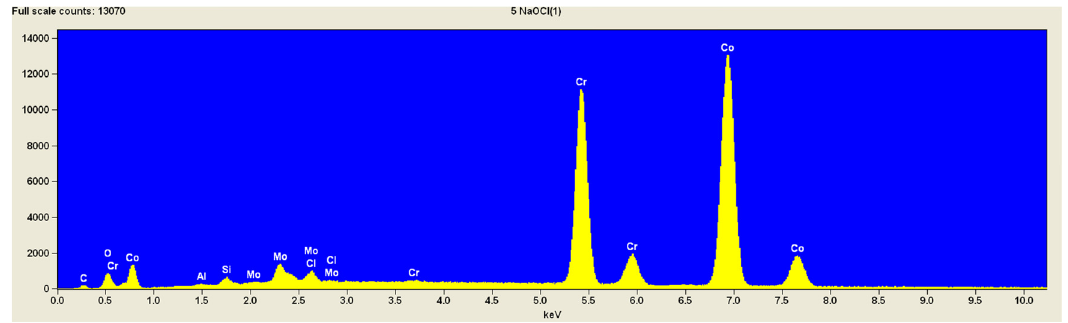
Figure 4: EDS analysis for the negative control group ( dry )